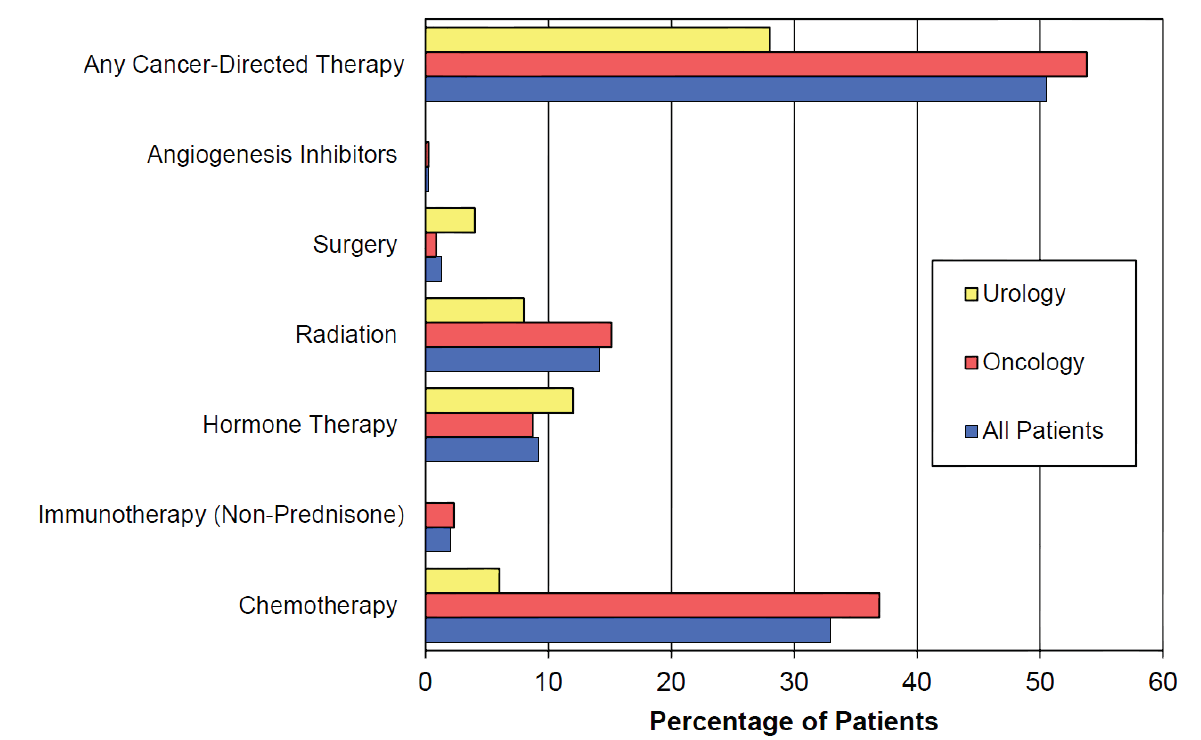
Figure 3. Additional Cancer-Directed Treatments Received After Docetaxel Discontinuation, by Specialty of Treating